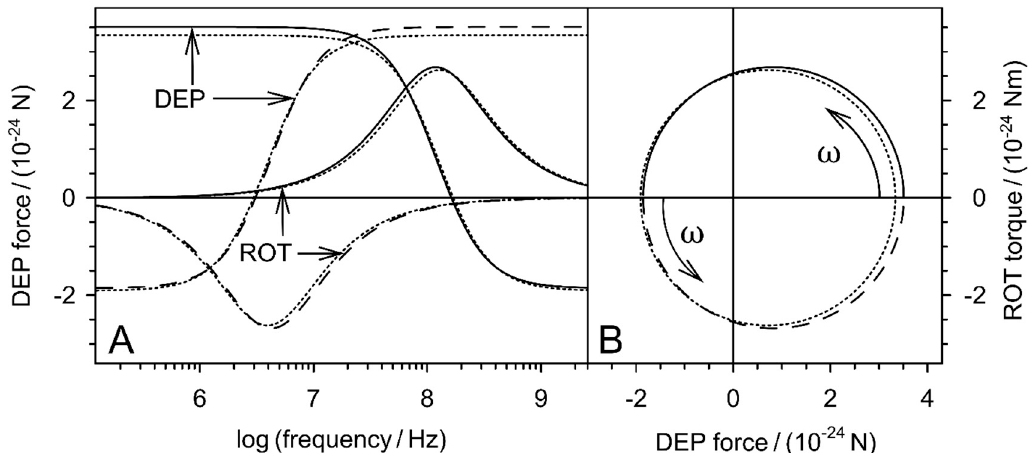
Figure 3. Frequency ( A ) and complex plots ( B ) of DEP-force and ROT-torque spectra of the two spheres of Figure 2 according to Equations (27) and (32) compared with the classical model (dotted lines; Equations (4), (7), (28) and (31)). All spectra were calculated for field strengths of 1 V/m. To obtain corresponding numerical values of forces and moments, the DEP forces were calculated for γ = 1 m − 1